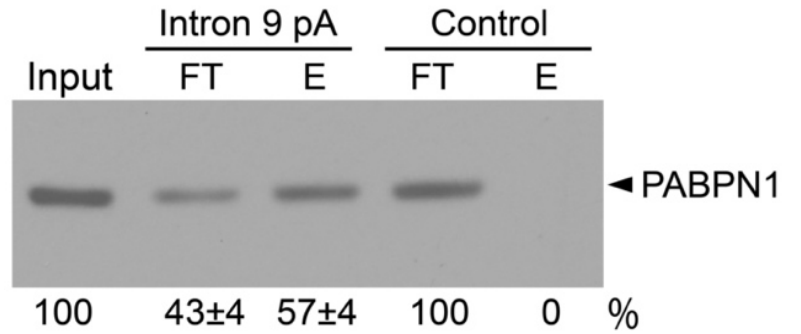
Figure 3. Interaction between PABPN1 and KCNH2 intron 9. Cell lysates from HEK293 cells were incubated with biotinylated and streptavidin bead–bound RNA probes corresponding to the KCNH2 intron 9 poly(A) signal and polyadenosine stretch or the negative control oligo containing the sequence from the 3 ′ UTR of androgen receptor mRNA. The RNA ‐ bound protein fractions (E) and unbound fractions (FT) were analyzed by immunoblotting with anti ‐ PABPN1 antibody. Signals were quantified and expressed as percentage of total (FT + E) protein (n = 3, mean ± S.E.).